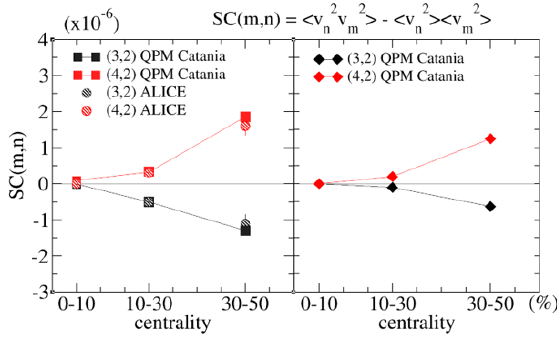
Figure 2. Centrality dependence of the Symmetric Cumulant Correlator for charged particles (left) and η < 0 . 8 and 0 . 5 < p < 5 . 0 GeV in PbPb collisions at √ s D mesons (right) with T | | circles in the left panel are the ALICE experimental data [22]. Figure from Ref.